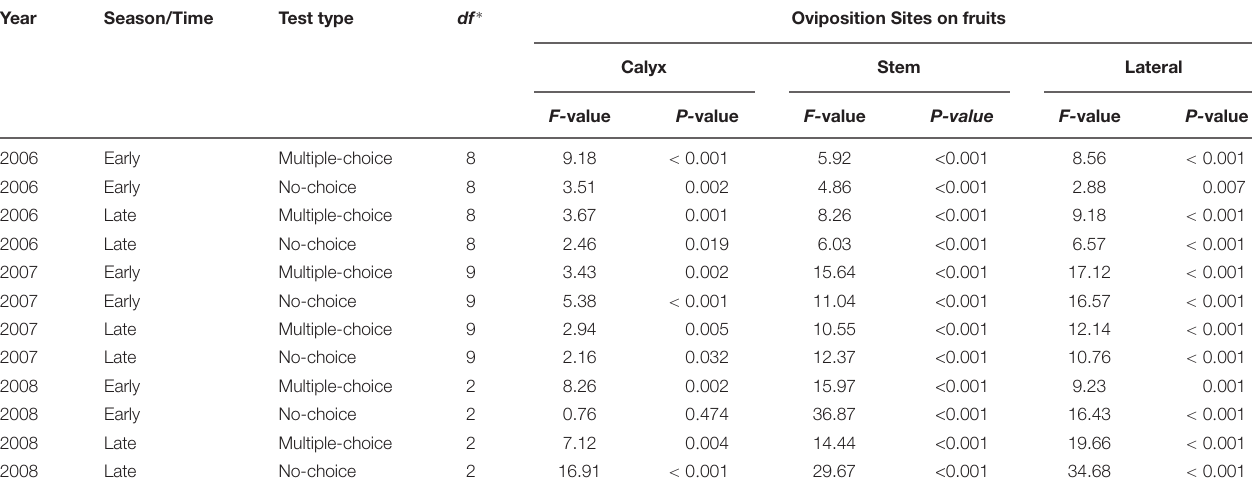
TABLE 4 | Statistical details of oviposition site preferences of codling moth across different cultivars.